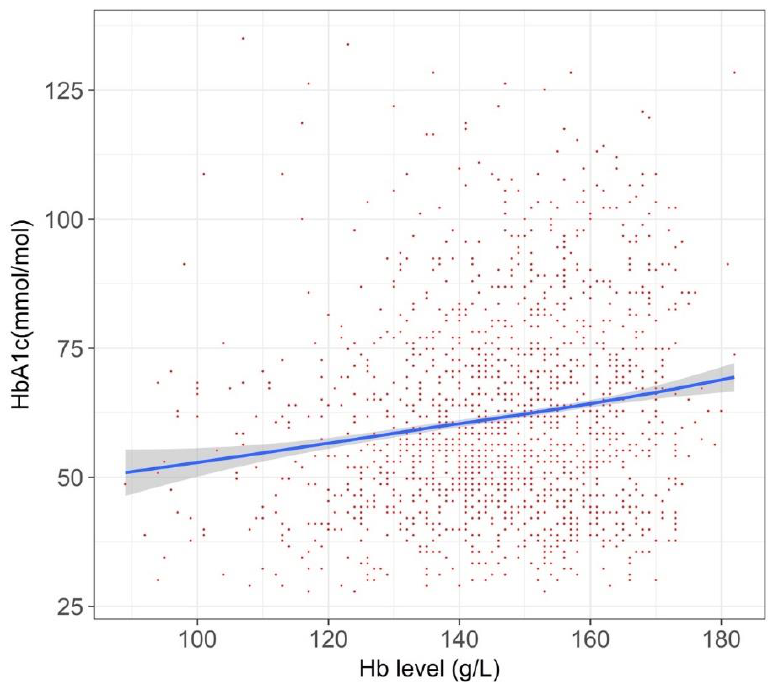
Figure 6. The relationship between Hb and HbA 1c values in persons in the T1DM cohort ( n = 598). T1DM — type 1 diabetes mellitus.